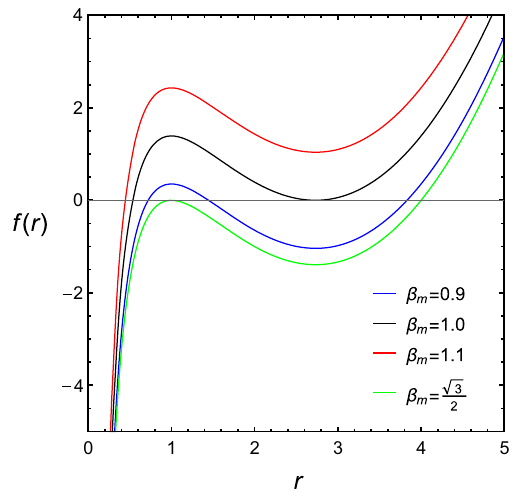
Fig. 2 Plot of f ( r ) using different values of β m , with M = 1 and c 2 = 1 β = 1, the second and the third horizons are merged, with m twohorizonsforthesetwospecificcases.Finally,onehorizon √ 3 / 2 (third horizon) and β m > 1 can exist for 0 < β m < (first horizon). This behaviour can be seen explicitly in Fig.